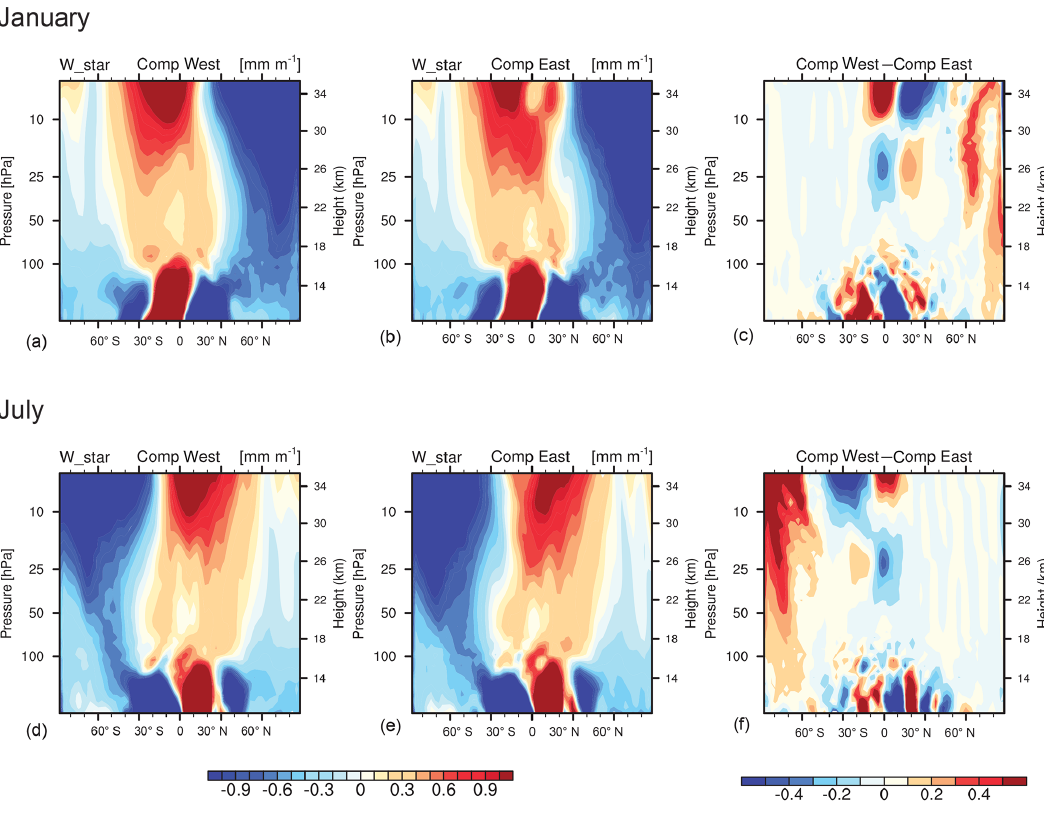
Figure 5. Zonally averaged residual vertical velocity ω ∗ for Composite West (a, d) and Composite East (b, e) of 4Tg60 for January (a–c) and July (d–f) and the difference of both composites (c, f) .